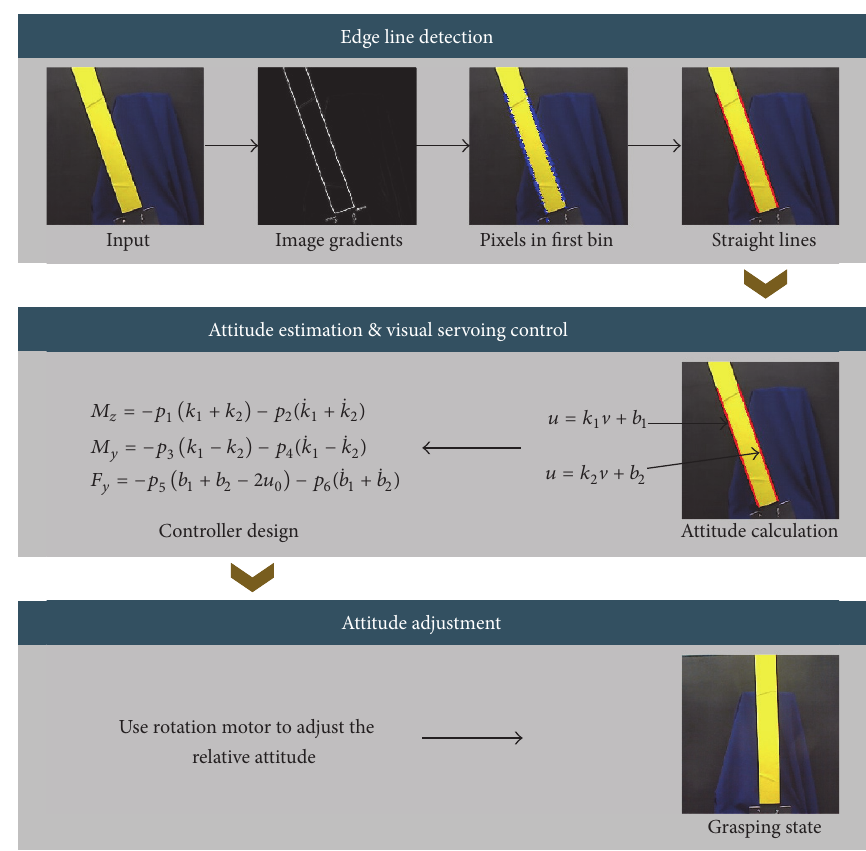
Figure 10: Flowchart of the proposed method.